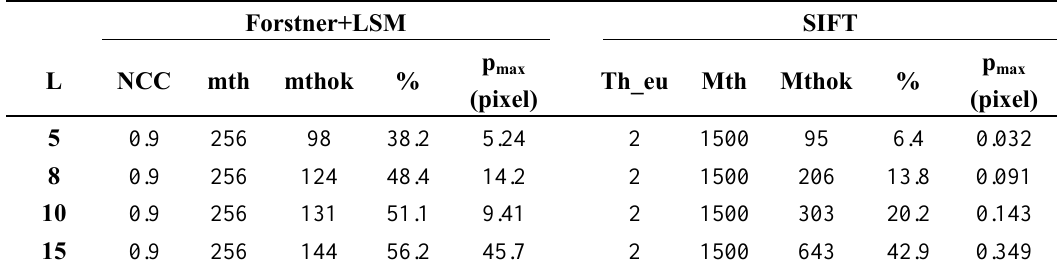
Table 3. The experimental results of the examined operators, in relation to the NCC , Th_eu and L